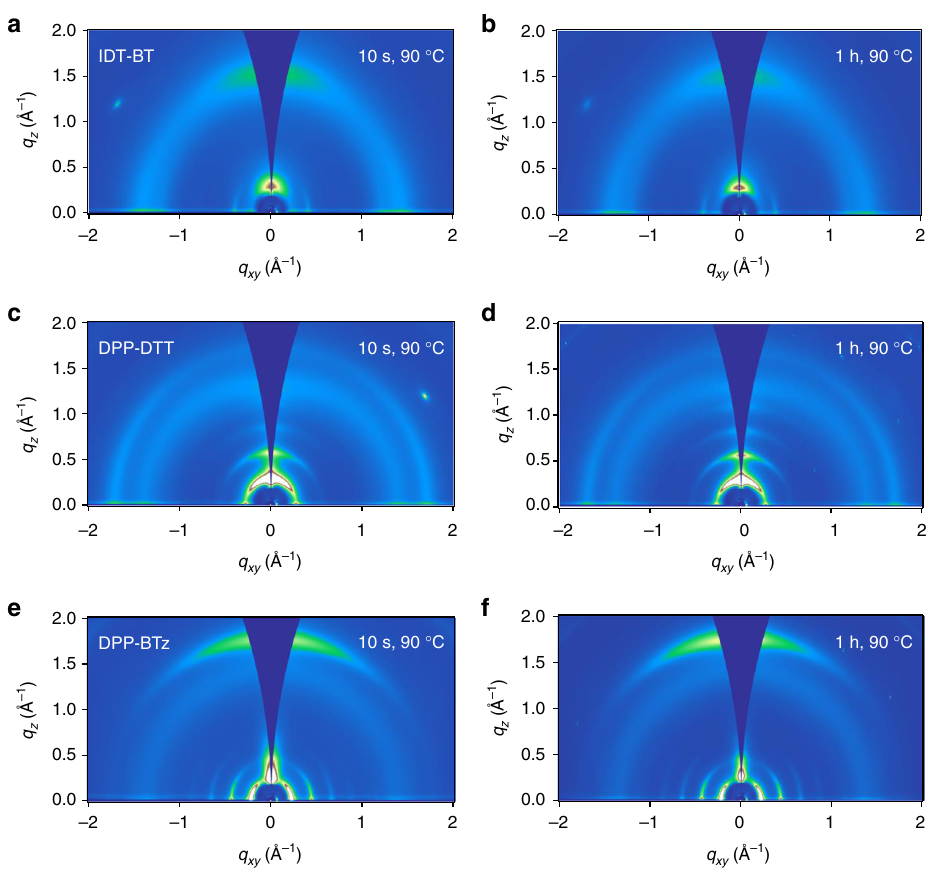
Fig. 4 Microstructure of polymer fi lms with and without a molecular additive grazing-incidence X-ray diffraction (GIWAXS) measurements of thick indacenodithiophene- co -benzothiadiazole (IDT-BT) ( a , b ), diketopyrrolo-pyrrole-dithiophene-thienothiophene (DPP-DTT) ( c , d ), and poly[[2,5-bis(2- octadecyl)-2,3,5,6-tetrahydro-3,6-diketopyrrolo[3,4- c ]pyrrole-1,4-diyl]-alt-(2-octylnonyl)-2,1,3-benzotriazole] (DPP-BTz) ( e , f ) fi lms on gold substrates; fi lms with the additive (residual 1,2-dichlorobenzene (DCB) solvent) are shown in a , c , e and fi lms with the additive removed are shown in b , d , f